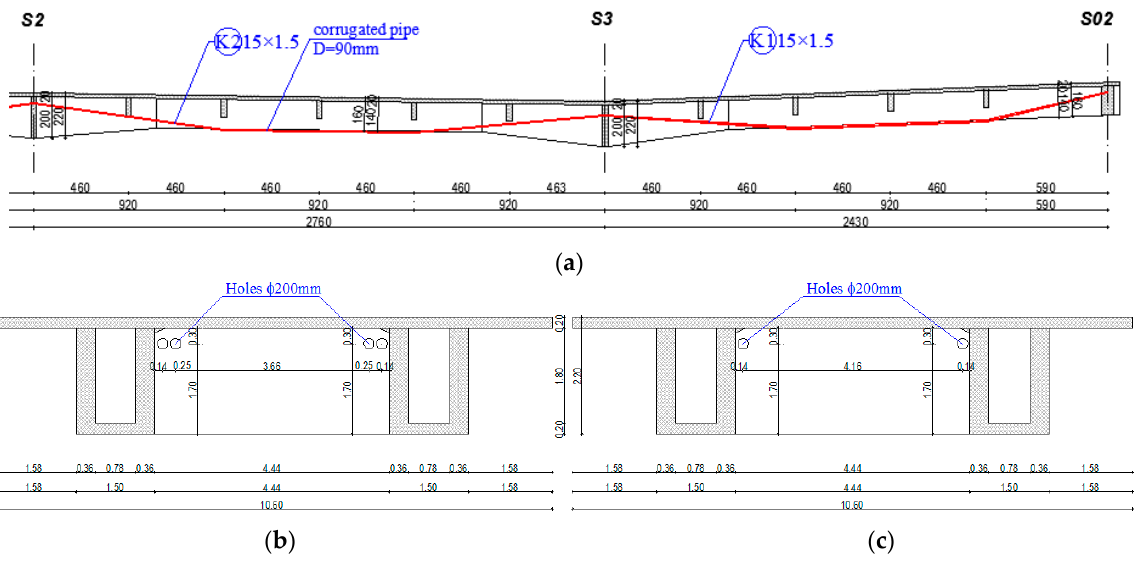
Figure 10. Layout of the prestressing cable tendons: ( a ) longitudinal section (half bridge) and ( b ) cross-section above piers S2 and S3 and ( c ) cross-section above pier S1.